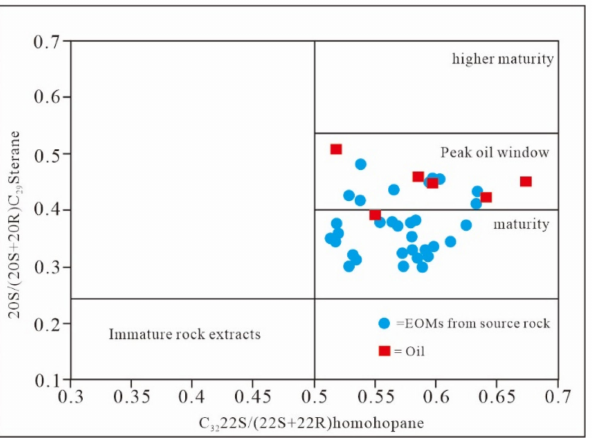
Figure 14. A cross plot of C29 sterane 20S/(20S + 20R) and C32 homohopane 22S/(22S + 22R), adapted from [21].